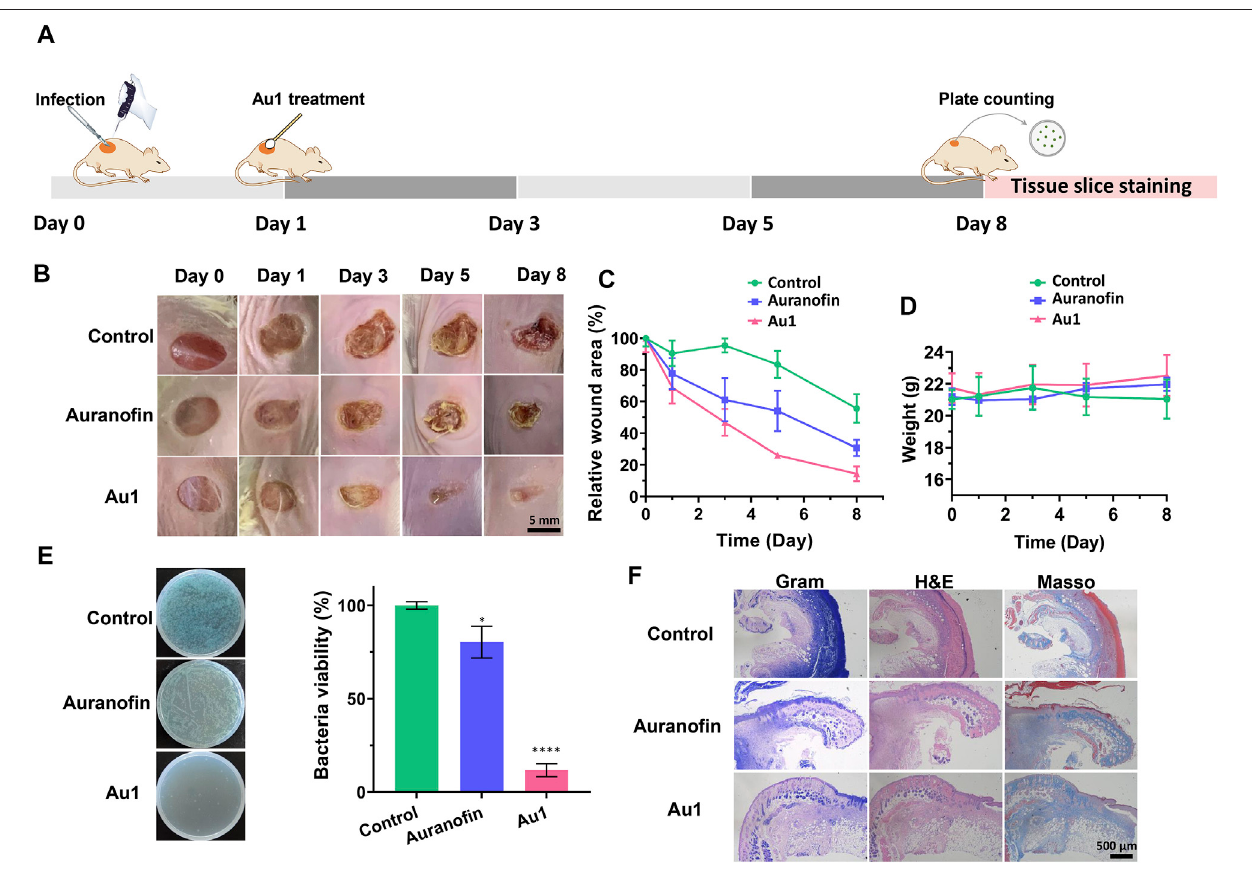
FIGURE6|(A) Schematicillustrationofthemiceinfectionexperiment. (B) Therepresentativeimagesandcurves (C) ofwoundareasofcontrol,arano fi n-,andAu1- treated groups. Scale bar: 5 mm. (D) Mice weight changes within 8 days in various experimental groups. (E) The representative images and quanti fi cation of P. aeruginosa bacteriain the mice wounds. All experiments are performed in triplicated and data are presented as mean ± sd. * means p < 0.05, ****means p < 0.0001. (F) Gram, H&E and Masson ’ s trichrome staining of mice wound tissues in various experimental groups. Scale bar: 500 μ m.